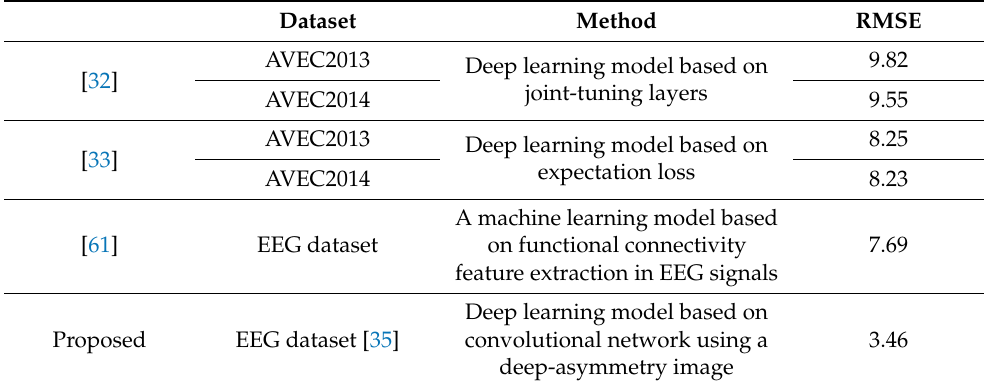
Table 8. Comparison of BDI prediction results from previous